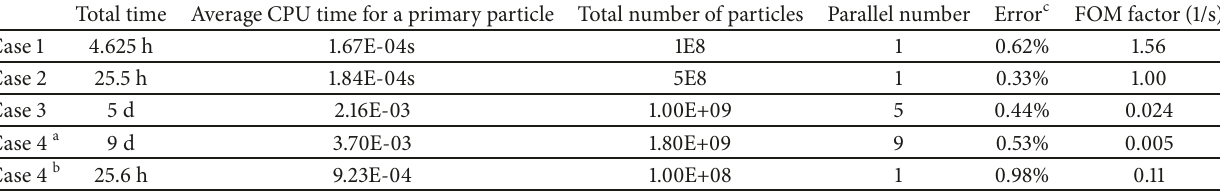
Figure 11: The corrected results of Cases 3 and 4 with the three groups of weights listed in equation (5) and comparison with other results. Table 4: Comparison of the calculation cost and efficiency of